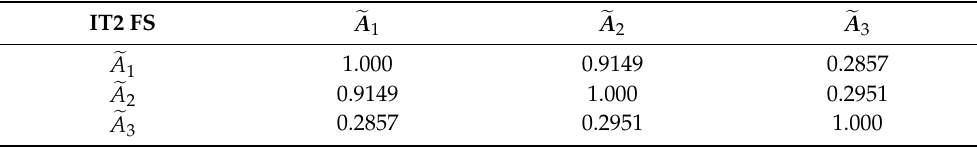
Table 8. Similarities among the overall scores in Figure